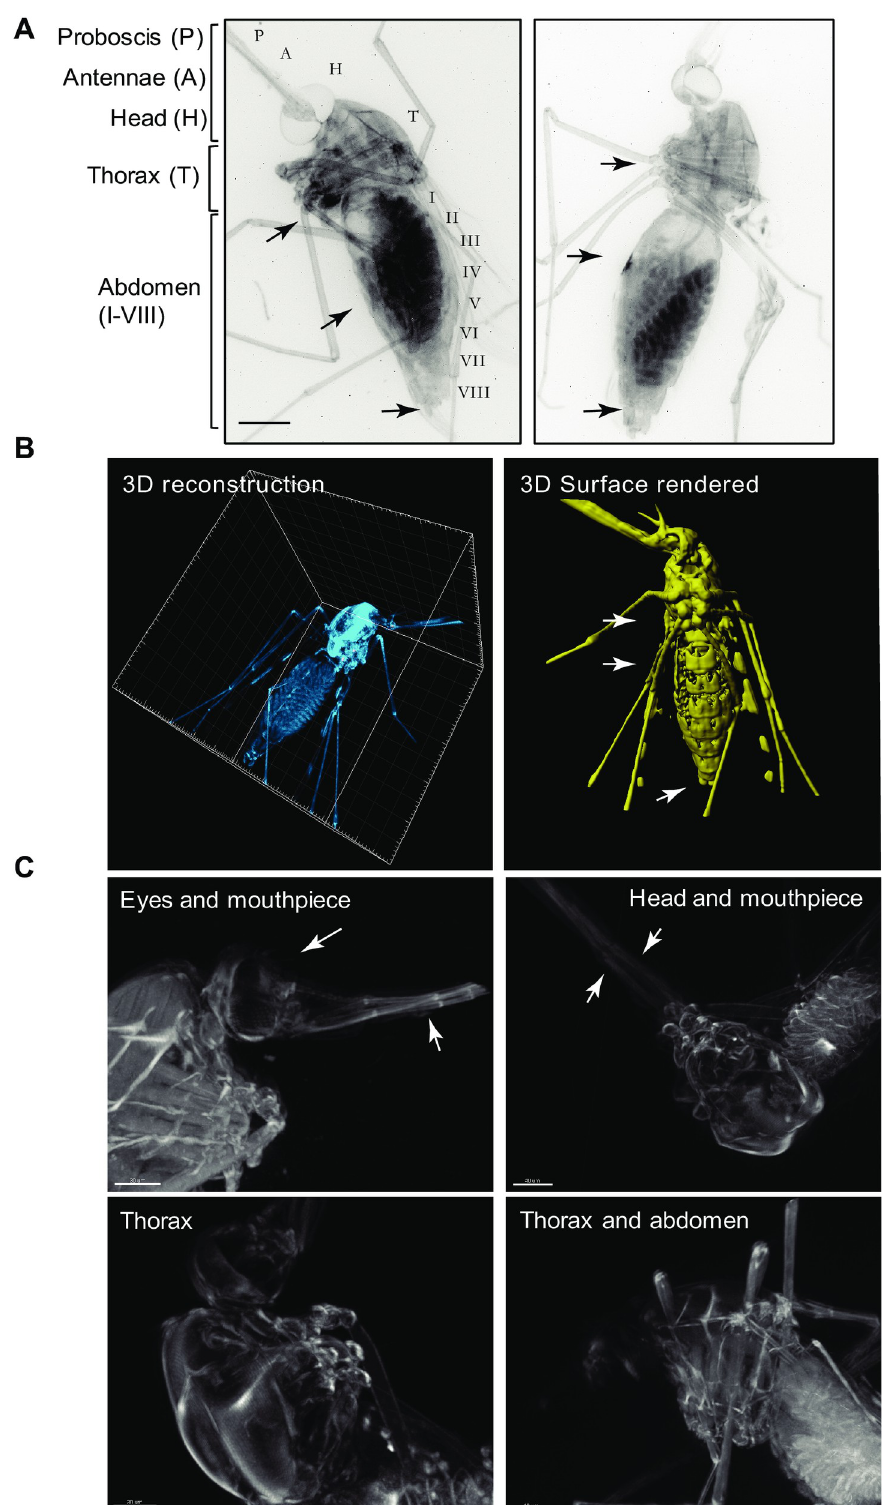
Fig 3. Visualization of an optically cleared Anopheles stephensi female mosquito. A) 2D reconstruction of two reconstructed mosquitoes showing detailed views of the head structures (H) including the antennae (A), and the proboscis (P) and the eyes. Detailed view of the thorax is also possible, as well as of all segments of the abdomen. Scale